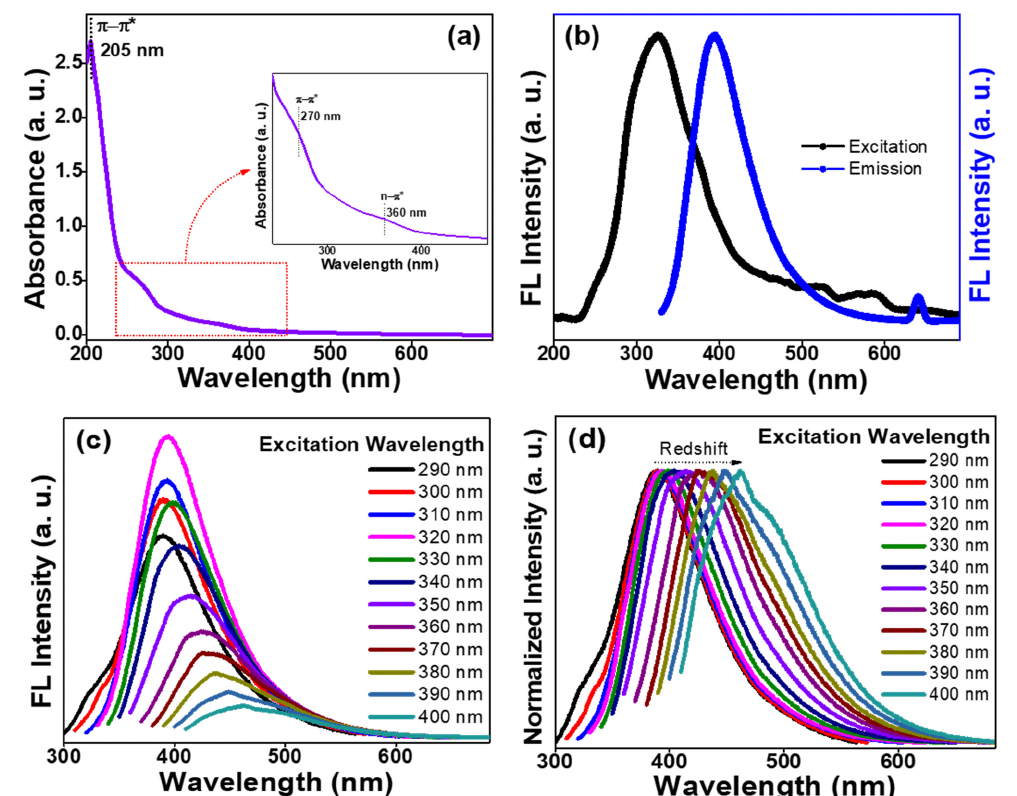
Figure 5. ( a ) UV–vis absorption spectrum of synthesized TC-CDs; ( b ) fluorescence excitation and emission spectra of the synthesized TC-CDs; ( c ) fluorescence emission spectra of the synthesized TC-CDs were measured with 10 nm increments of excitation wavelength in the range from 290 to 400 nm, and ( d ) the corresponding normalized fluorescence emission spectra.